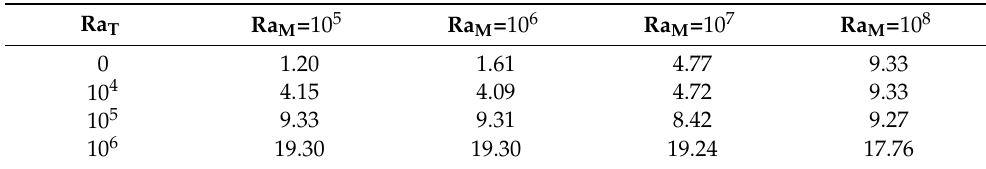
Table 2. dependency of the average Nusselt number on the Ra T and Ra M when 𝑛 = 0.8 , 𝜆 = 0 , Pr = 100 , 𝛽 (cid:3030) = 60 , 𝛿 = 30° and 𝐿 = 0.3 .